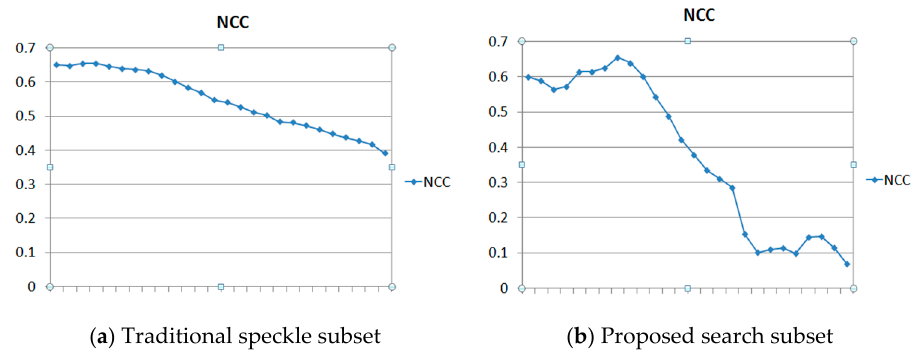
Figure 13. Normalized cross-correlation coefficient (NCCC) curves.